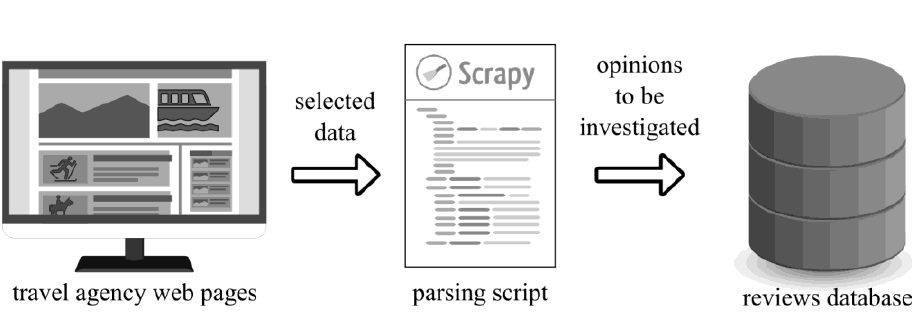
Fig. 3. The data extraction